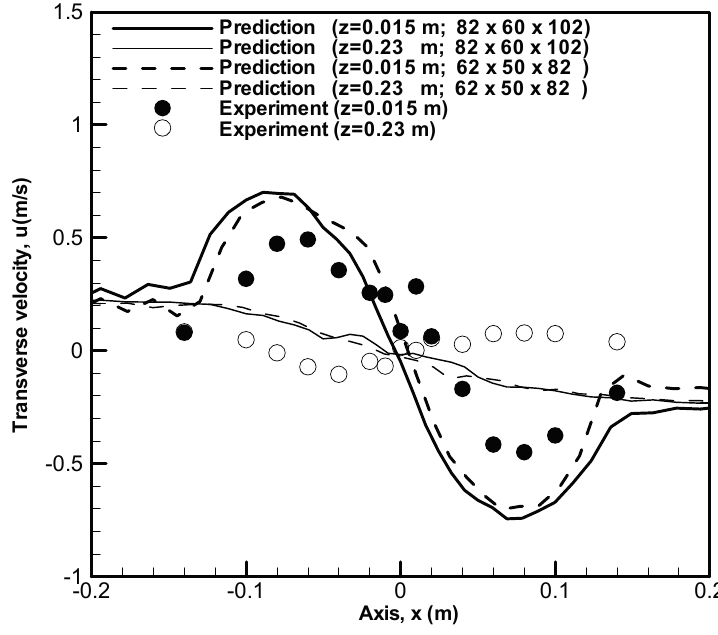
Figure 5. Profiles of the measured and predicted transverse velocity at z = 0.015 and 0.23 m. Orloff [15] performed detailed measurement for the chemical species, such as CO and soot, from a low Froude number propane and propylene-free pool fire of 178 kW by using a porous burner of 0.75 m in diameter. Based on the fire characteristic length, a grid system containing 70( x ) × 70( y ) × 100( z ) with uniform cell sizes of 2 cm is chosen. The predicted CO molar fraction in a traverse versus radial position at H = 5.2 cm and along the centerline against the average mixture fraction, Z , is plotted in Figure 6. The magnitude of CO is well predicted, and the computed profiles exhibit the same similarity that is observed experimentally. The peak in the carbon monoxide is predicted just inside the flame, and